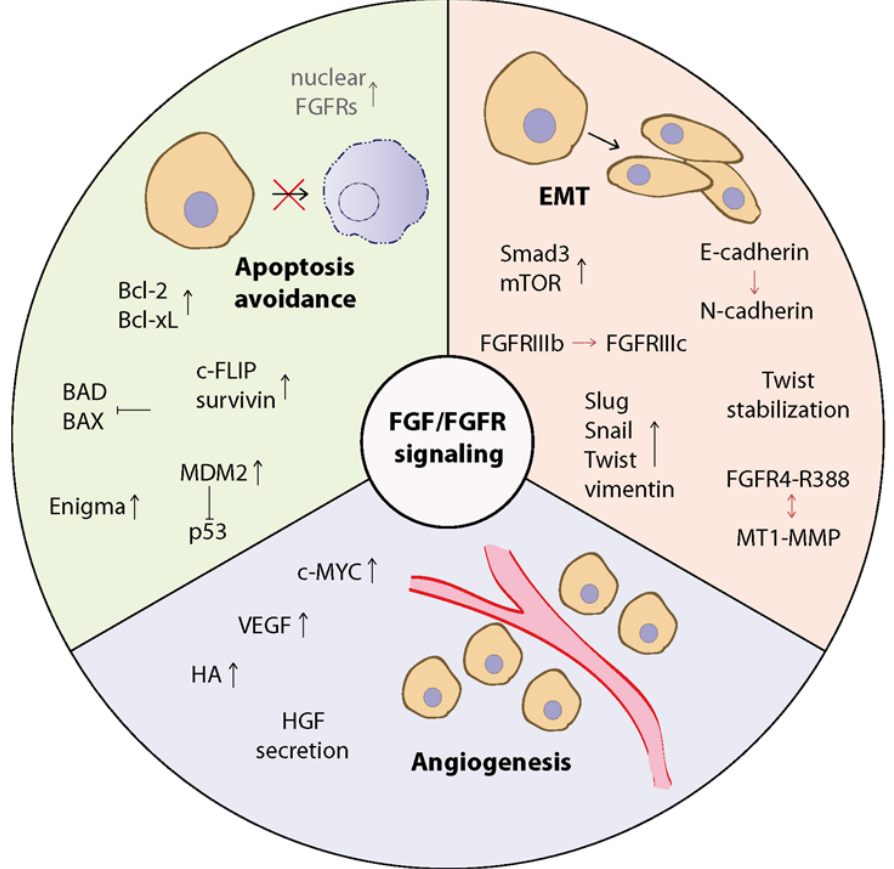
Figure 3. Involvement of FGF/FGFRs in cellular processes during the development of drug resistance. The active FGF/FGFR complex leads to avoidance of apoptosis through increased expression of apoptosis inhibitors (Bcl-2, Bcl-xL), inhibition of its activators (BAD, BAX) or activation and stabilization of MDM2, with consequent increased ubiquitination and degradation of p53. Additionally, p53 degradation can be enhanced by the formation of a ternary complex of p53, MDM2, and Enigma protein. Another mechanism of action is indirect inhibition of caspase 3/7 and caspase 8 by increasing the expression of survivin or c–FLIP, respectively. It is also likely that increased nuclear localization of FGFRs may be associated with enhanced survival of cancer cells and development of drug